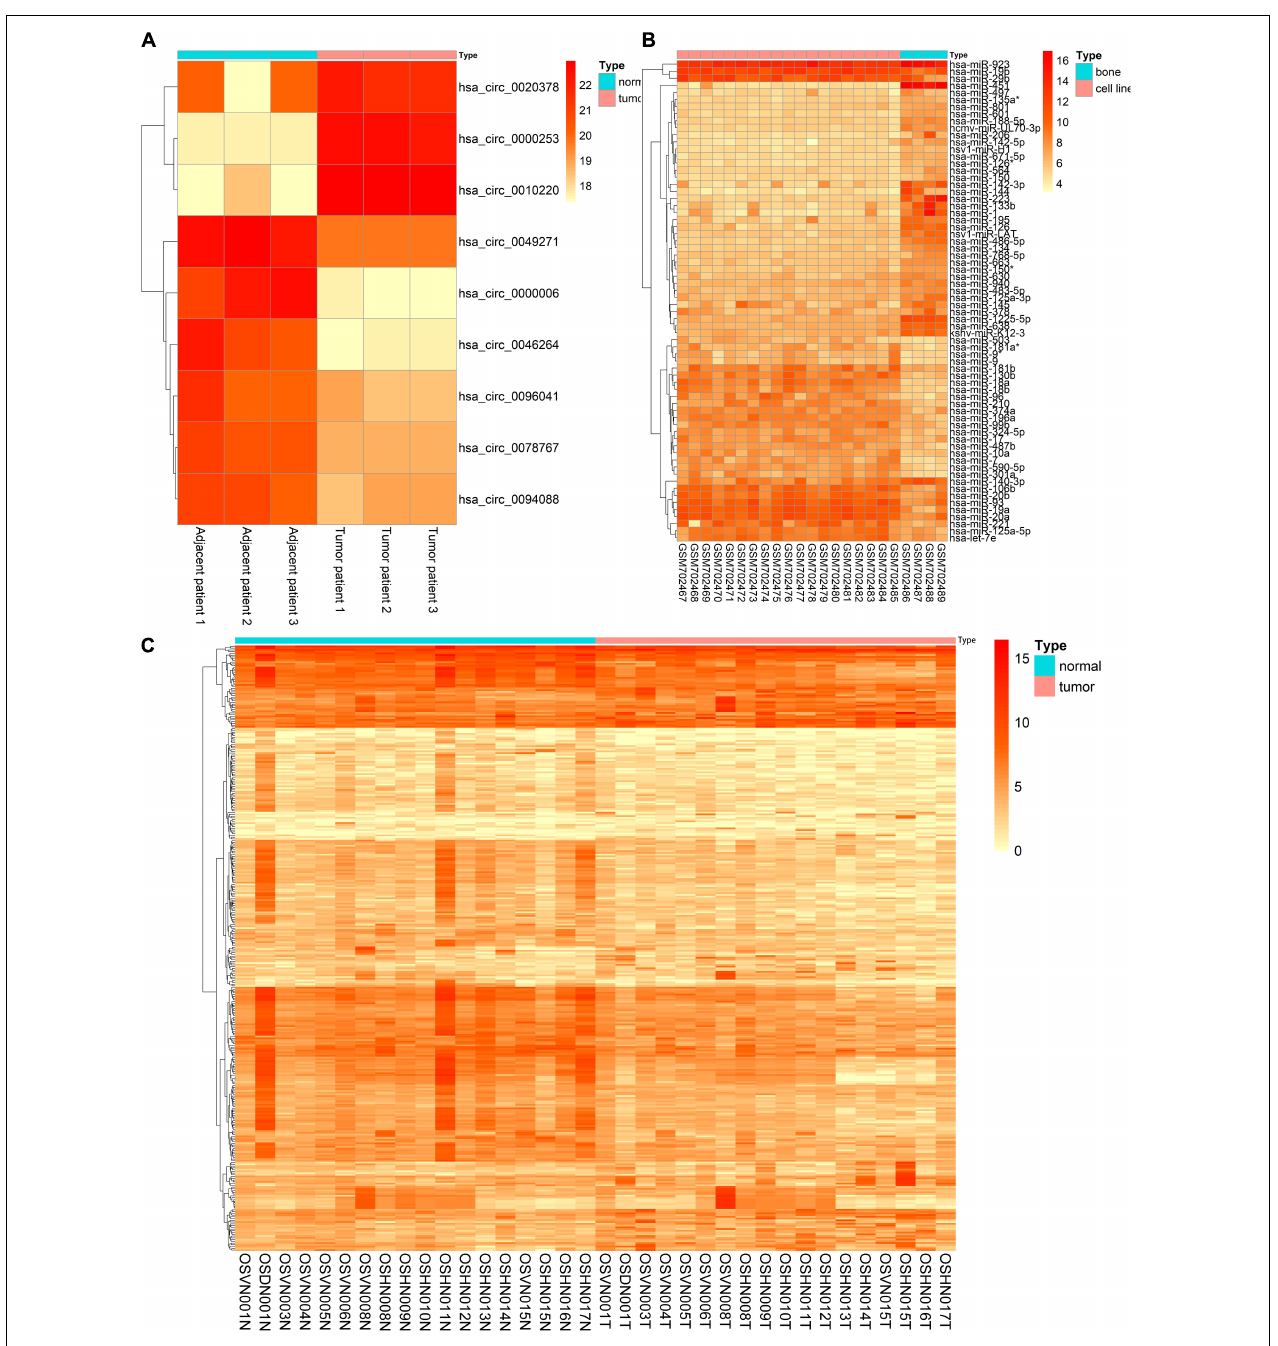
FIGURE 2 | The heatmaps of differentially expressed circRNAs (A) , miRNAs (B) , and mRNAs (C)